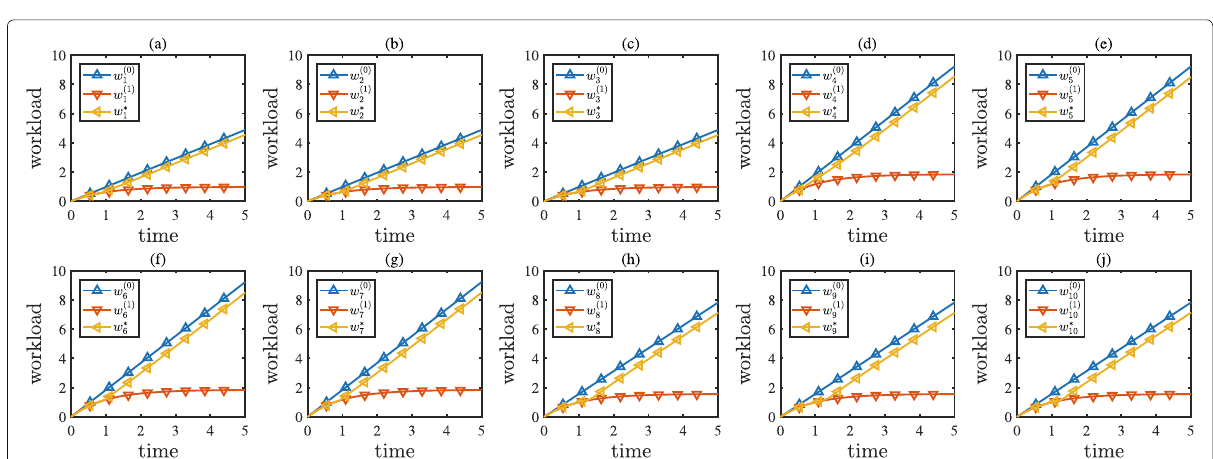
Fig. 9 The workload distribution evolution obtained from Example 2, where ( a ) to ( j ) show the workload dynamics of servers s 1 , s 2 , ... , s 10 in order